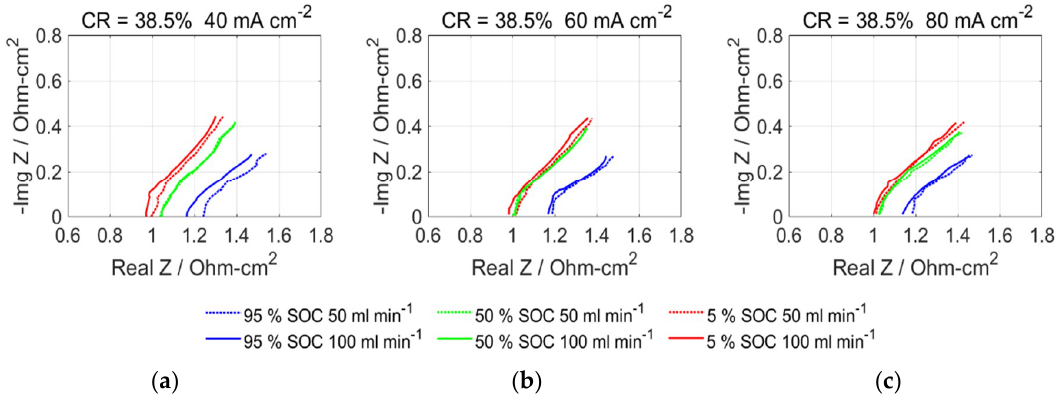
Figure 5. Nyquist plots of EIS of the VRFB under various operating conditions at CR = 23.1%: ( a ) 40 mA cm −2 ; ( b ) 60 mA cm −2 ; ( c ) 80 mA cm −2.